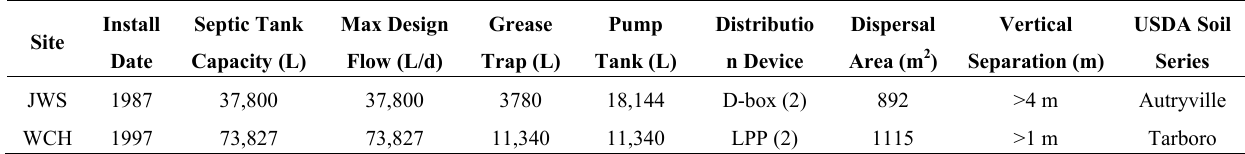
Table 1. Site and wastewater system